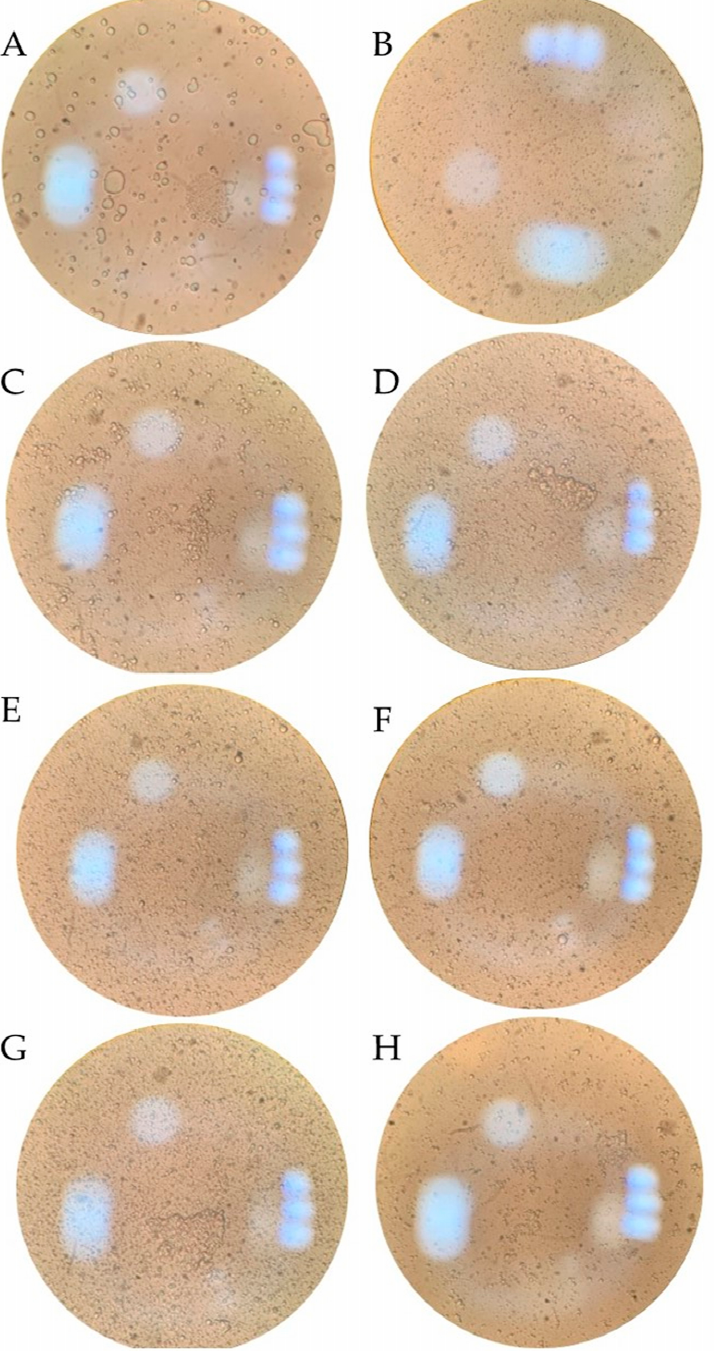
Figure 1. Optical 100× light microscope images of ( A ) raw milk, ( B ) homogenized (HM) ultra-pasteurized milk, ( C ) HM 400 MPa, 5 min-treated milk, ( D ) HM 400 MPa, 10 min-treated milk, ( E ) HM, 500 MPa, 5 min-treated milk, ( F ) HM 500 MPa, 10 min-treated milk, ( G ) HM 600 MPa, 5 min-treated milk and ( H ) HM 600 MPa, 10 min-treated